Question: Provide a publication-style caption for this figure.
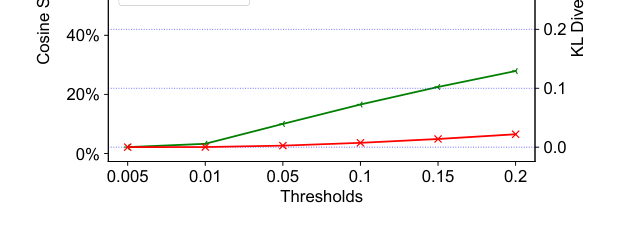
Answer: Information leakage with different thresholds. Co- sine similarity and KL divergence between two latent-space images are used to test the effect of information preserv- ing. With the increase of threshold, the similarity between the encrypted image and the original image will decrease, while the plain image becomes more similar with the origi- nal one. Considering that the behavior of similarity keeps stable in each iteration, the last iteration is chosen for the experiments.